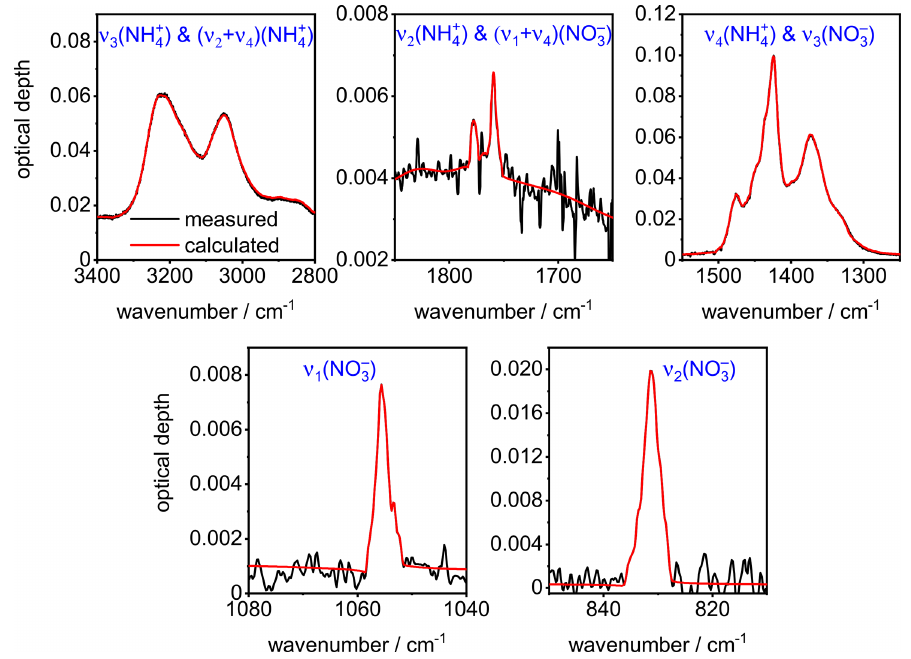
Figure A1. Comparison between the measured (black lines) and the computed (red lines) infrared extinction spectrum of crystalline AN particles in five different wavenumber regimes after convergence of the minimization algorithm with n( ˜ ν x ) = 1 . 56, χ = 1 . 1, and ϕ = 1. The notation of the AN vibrational modes is according to Fernandes et al. (1979).